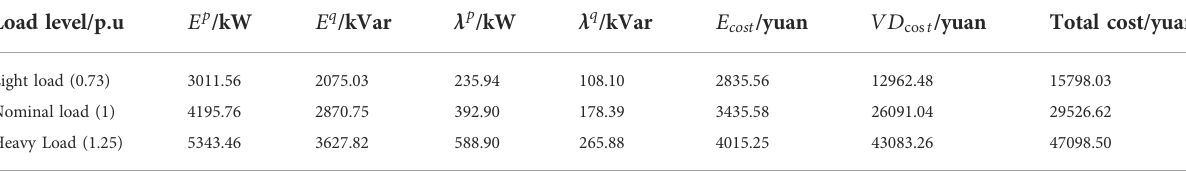
TABLE 4 Energy and voltage control cost for distribution network with high permeability electric vehicle. Load